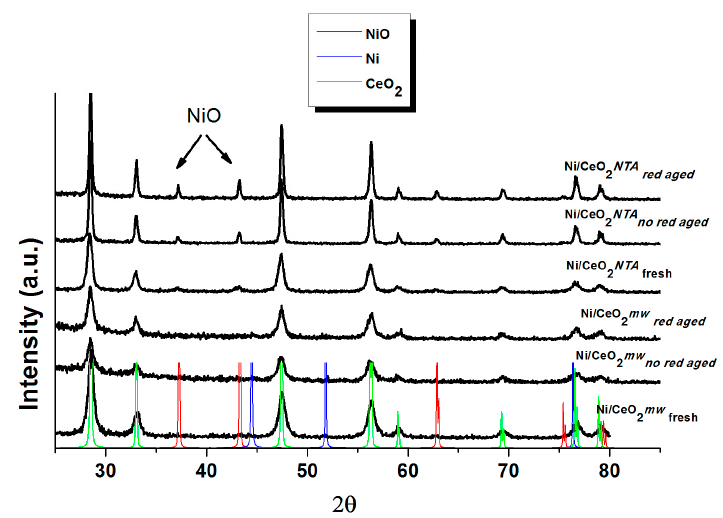
Figure 8. XRD pattern of the two differently prepared samples as fresh and after the CPO cycle performed on the reduced and the un-reduced catalysts.